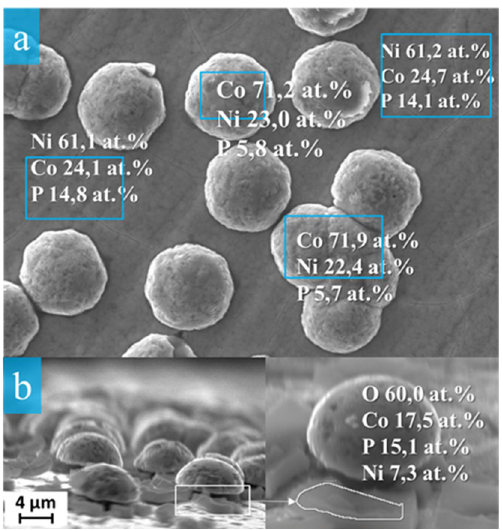
Figure 4. The microstructure and composition of individual sections of the CoNiP20 coatings ( a ) as well as an agglomerate side view ( b ).